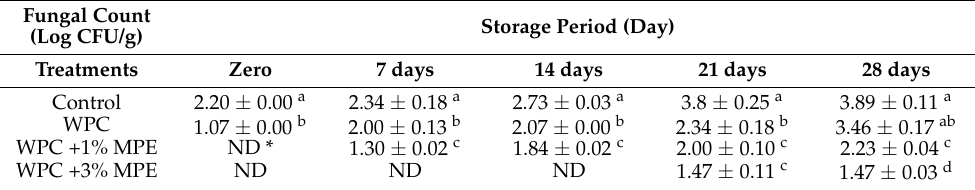
Table 5. Fungal count (CFU/g) of broccoli fresh-cuts treated with different coating (WPC = whey protein concentrate alone, WPC + 1% MPE = whey protein concentrate + mango peel extract at 1% and WPC + 3% MPE = whey protein whey protein concentrate + mango peel extract at 3%) during 28 days of cold